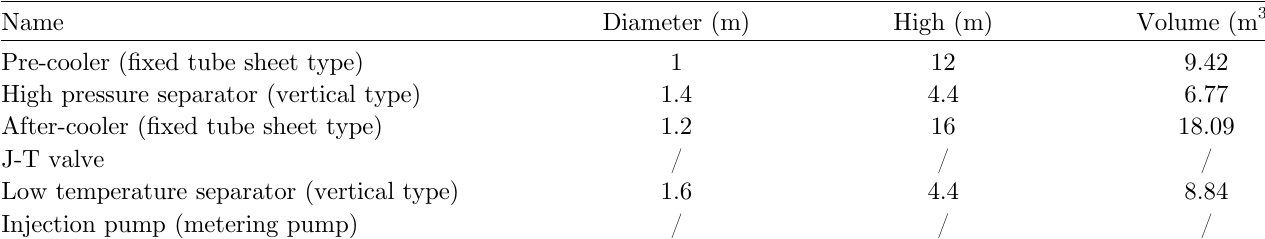
Table 4. Process equipment size.